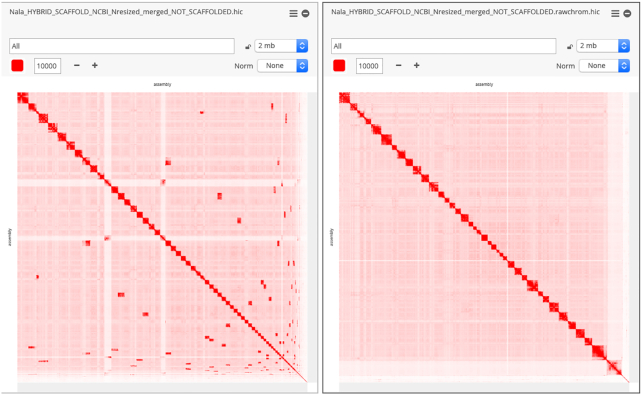
GSD assembly before and after Hi-C correction. Contact matrices (visualized in Juicebox.js) comparing the GSD assembly before and after the chromosome-length Hi-C upgrade.